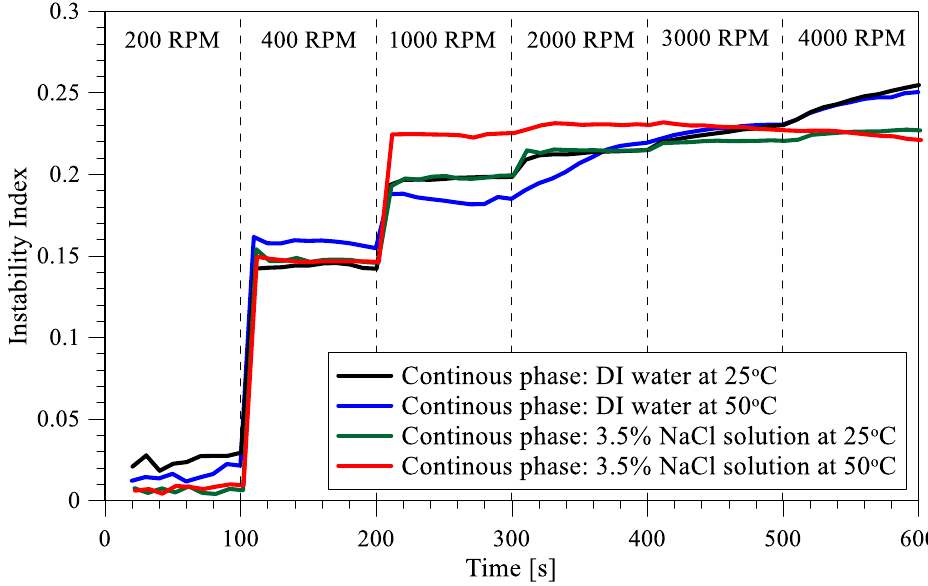
Figure 6. Instability index of the prepared emulsions at various rotational frequencies and temperature of 25 °C and 50 °C.